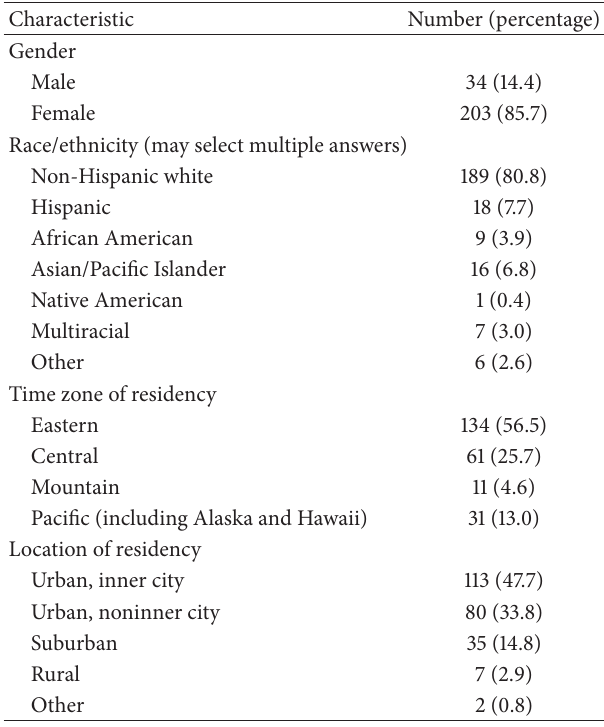
Table 1: Demographic and residency program information of respondents, year 2014 ( 𝑁 = 238